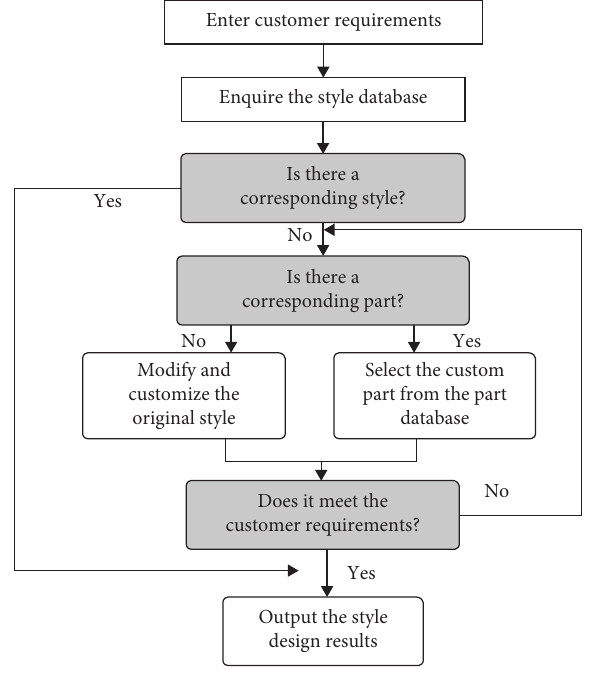
Figure 7: Custom design process of styles.